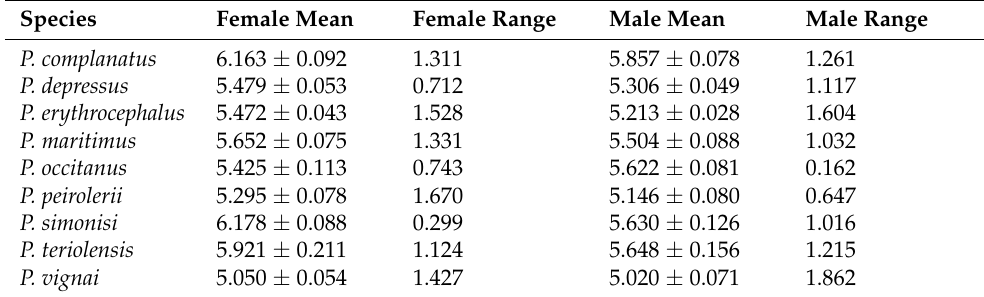
Figure 3. Boxplot of the CS values of the pronotum in the Platynus species. The sexes were examined separately. A common pattern is identified in all the species, with the females usually larger than the males. The numbers correspond to the Platynus species: 1 = P. complanatus ; 2 = P. depressus ; 3 = P. erythrocephalus ; 4 = P. maritimus n. sp . ; 5 = P. occitanus n. sp . ; 6 = P. peirolerii ; 7 = P. simonisi n. sp . ; 8 = P. teriolensis ; 9 = P. vignai n. sp . Table 1. Descriptive statistics of the body size (i.e., CS values of pronotum) in the Platynus species, with females and males treated